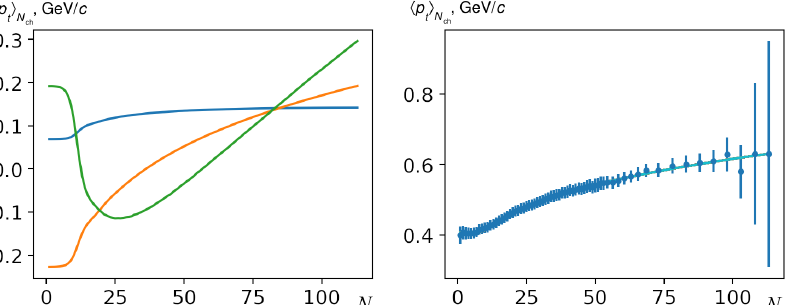
Figure 8. An example of the application of the method of the main component for pp collisions at 2.36 TeV. The first three main components of the (cid:104) p t (cid:105) - N ch correlation function obtained in the model are shown on the left. Right—decomposition of experimental data on these main components (closure